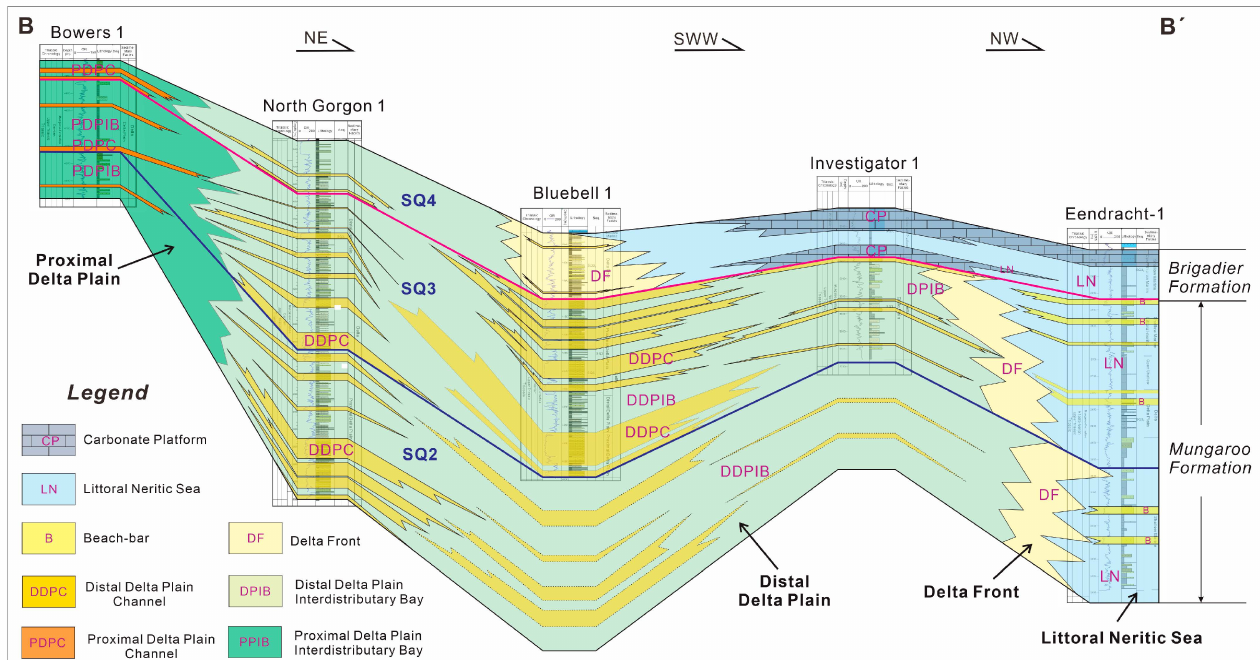
Figure 6. Cross-well profile B–B (cid:48) showing the sedimentary facies (proximal delta plain chan- nel/interdistributary bay, distal delta plain channel/interdistributary bay, delta front, beach bar, carbonate platform, and littoral neritic sea) of the shallow-water delta system of the Middle–Late Triassic Mungaroo and Brigadier Formation (BF) from SQ2 to SQ4. The scale of the delta is gradually decreasing accompanied by vertical changes in the sedimentary facies and lithologic association. See Figure 1a for the location of the cross-wells profile B–B (cid:48)